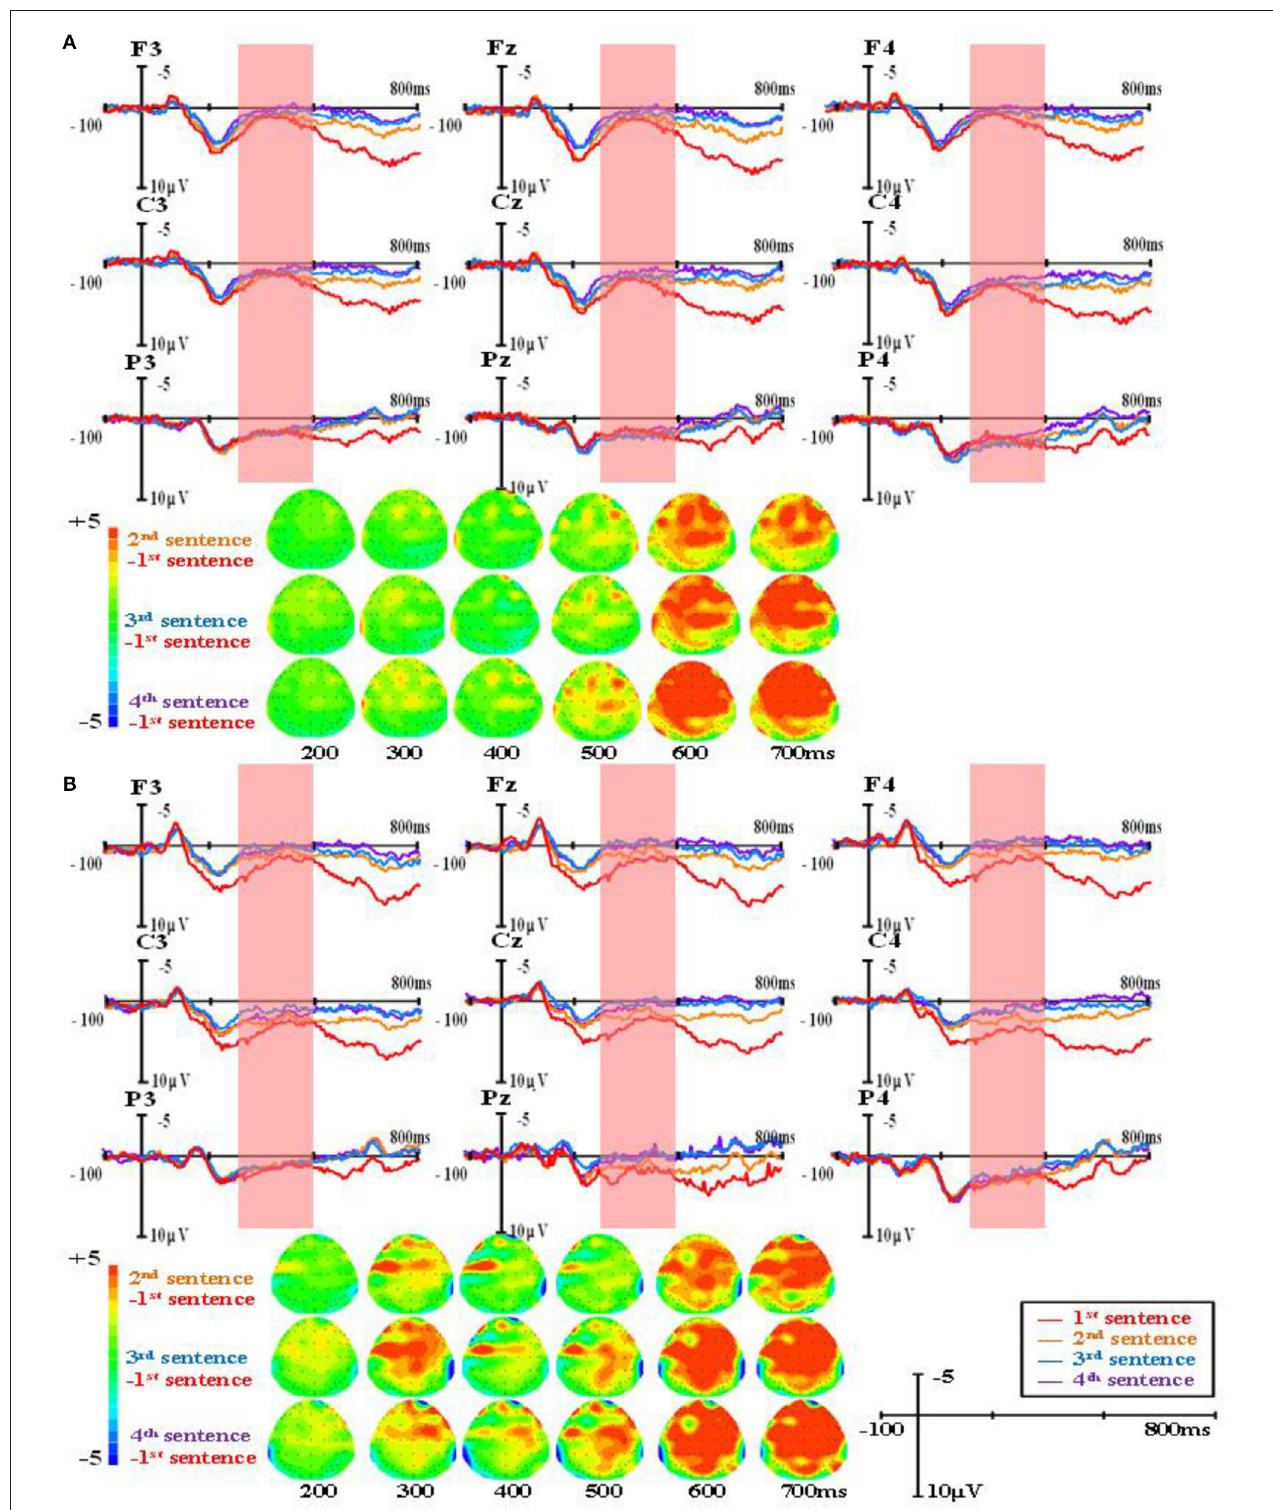
FIGURE 3 | The group-level average waveforms and scalp distribution elicited by pseudowords of four sentences (M + condition) for higher proficiency (A) and lower proficiency participants (B) .